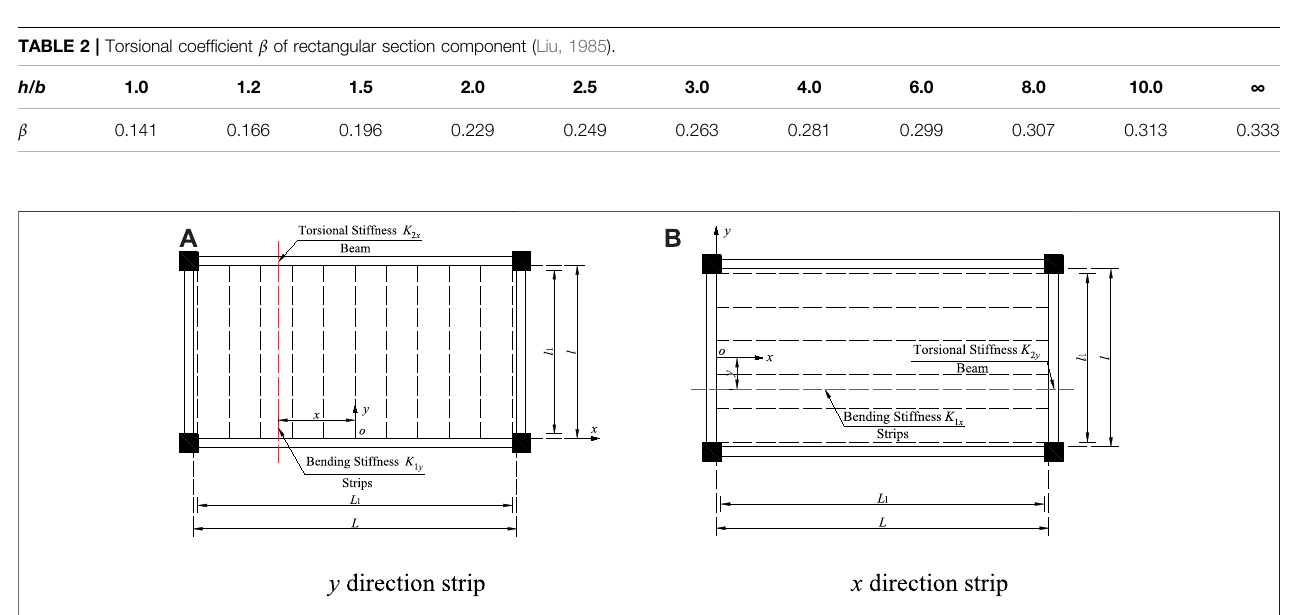
torsional coef fi cient of the rectangular section member ( Table 2 ). h and b are height and width of the beam, respectively.